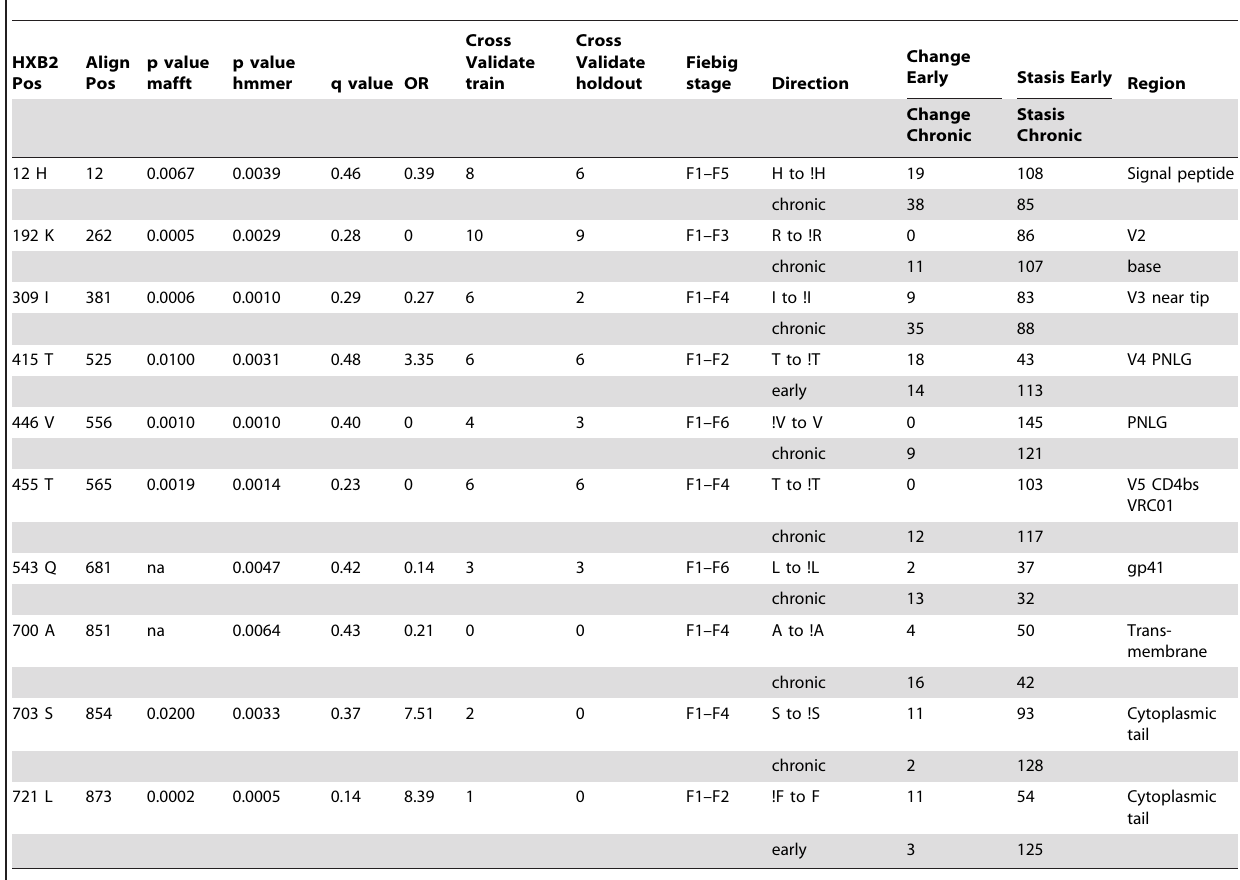
Table 4. Signature hypotheses raised based on analysis of all within-subject consensus sequences.